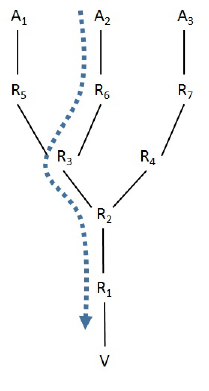
Figure 3. Theoretical Attack Graph